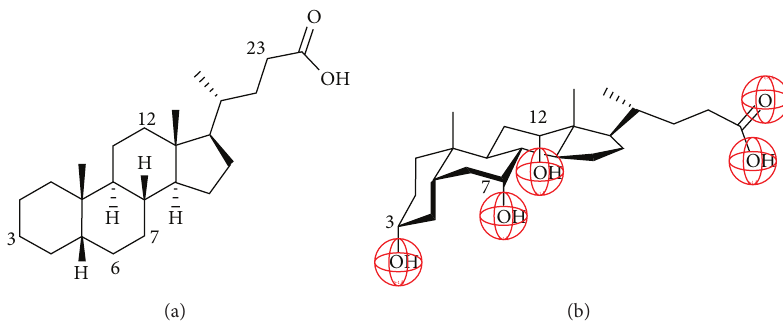
Figure 1: The structure of cholanic acid (CnA, (a)) and the steric presentation of cholic acid (CA, (b)). Table 1: Solubility and CMC data of bile acids and their oxoderivatives taken from the literature.